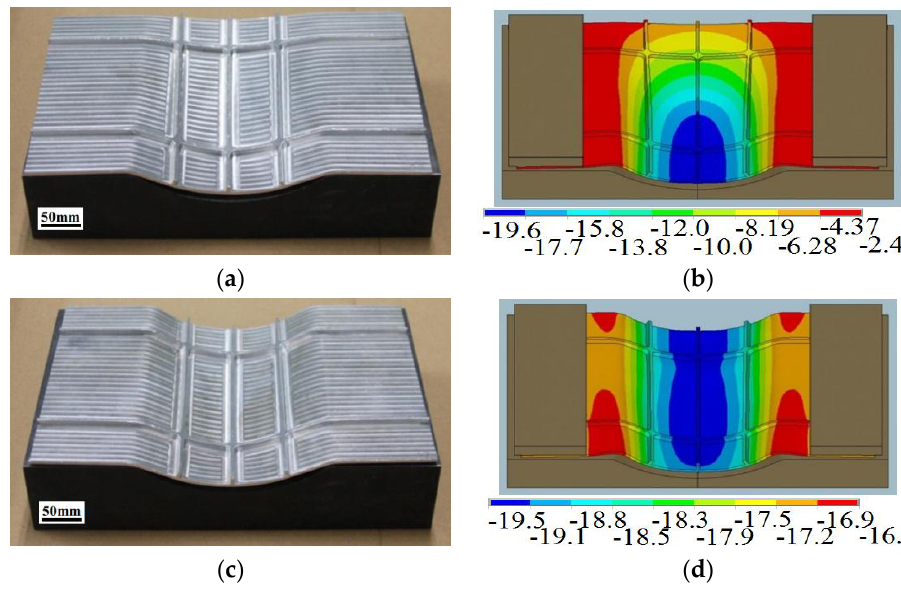
Figure 12. Profile comparisons between the experimental and simulated results: ( a , b ) experimental and simulated results after station A, respectively; and ( c , d ) experimental and simulated results after station C, respectively. The units for ( b ) and ( d ) are both millimeters.